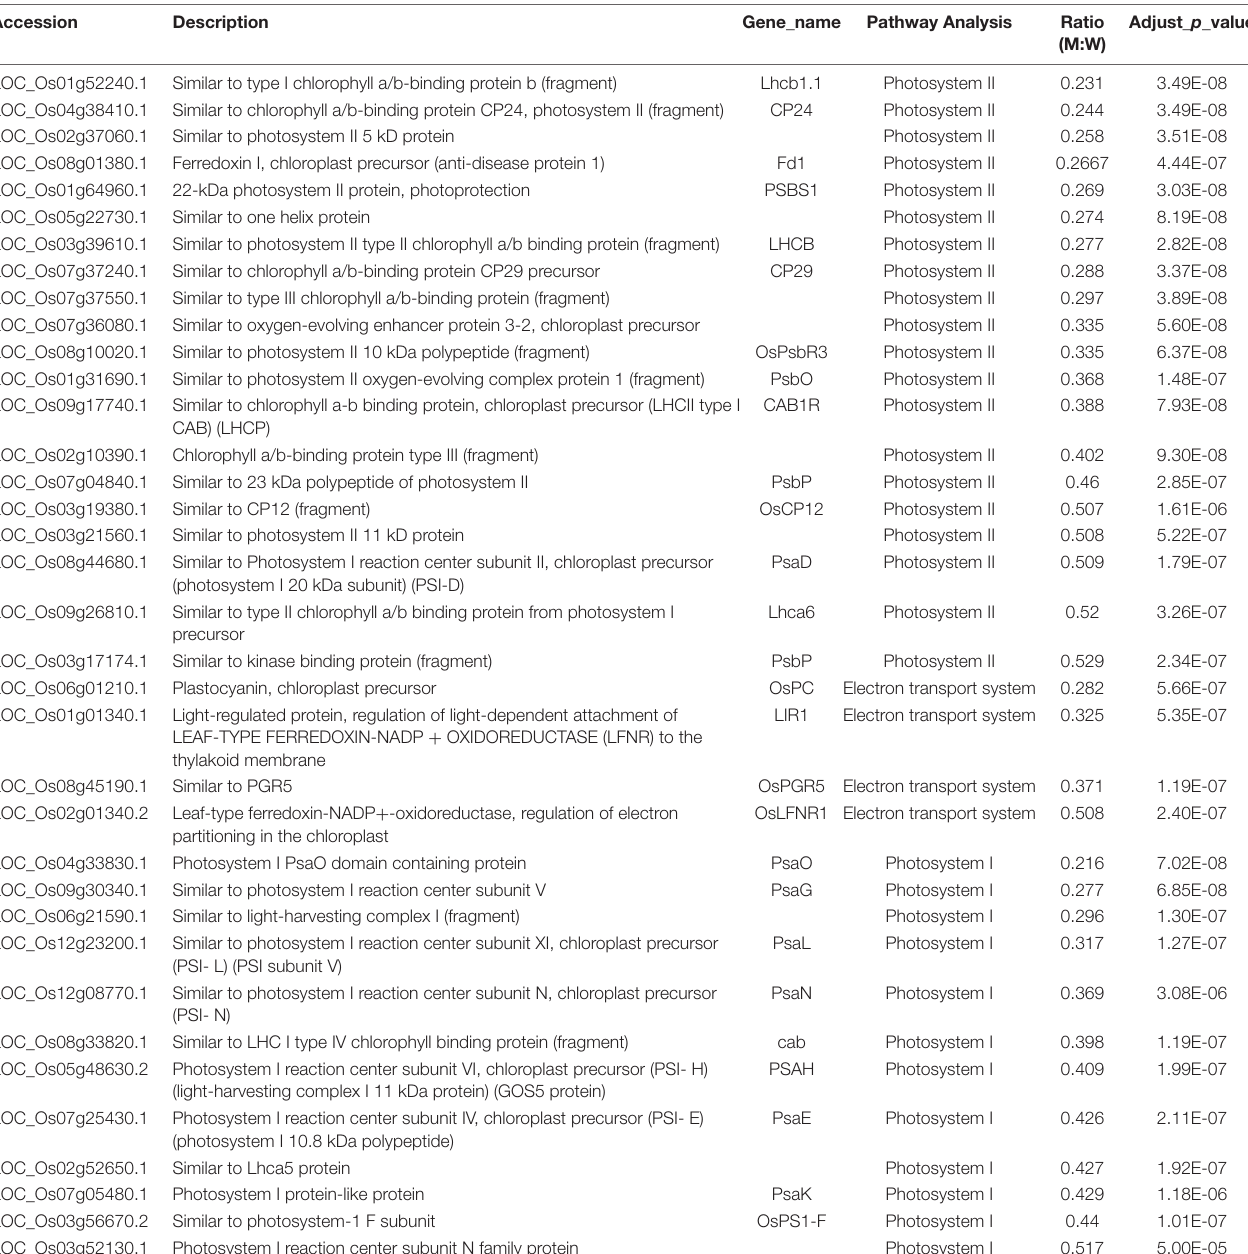
TABLE 2 | Nuclear-encoded thylakoid protein with significant fold changes in